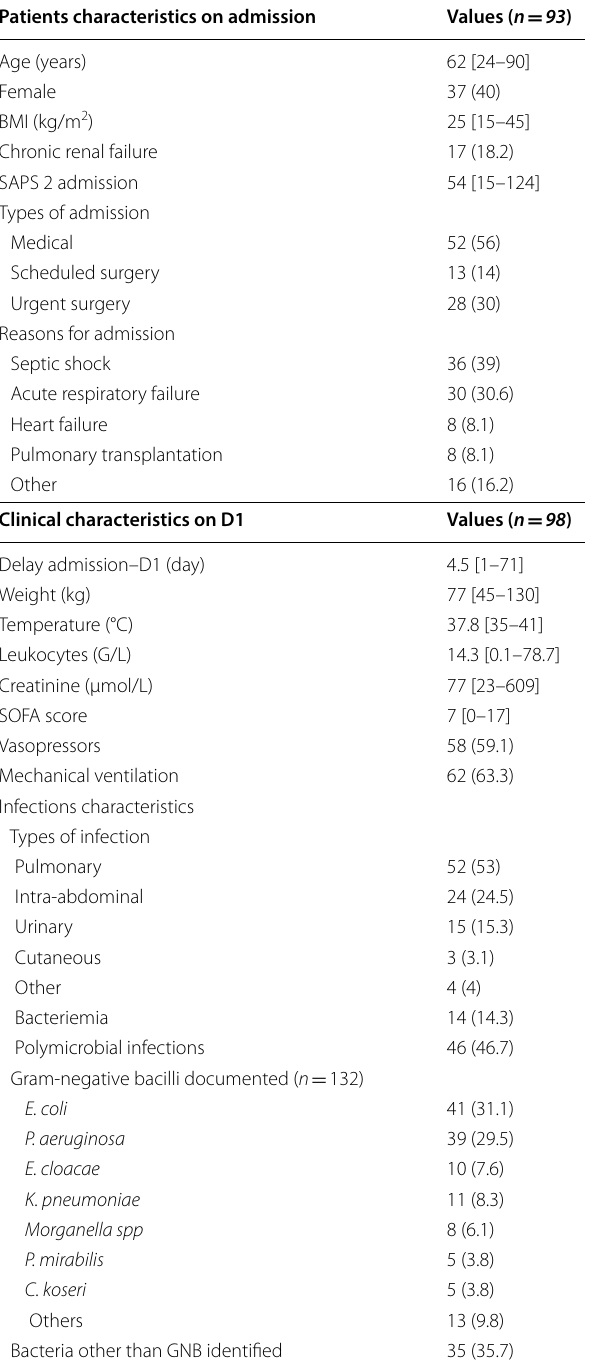
Table 1 Patients and infections characteristics on admission and on D1